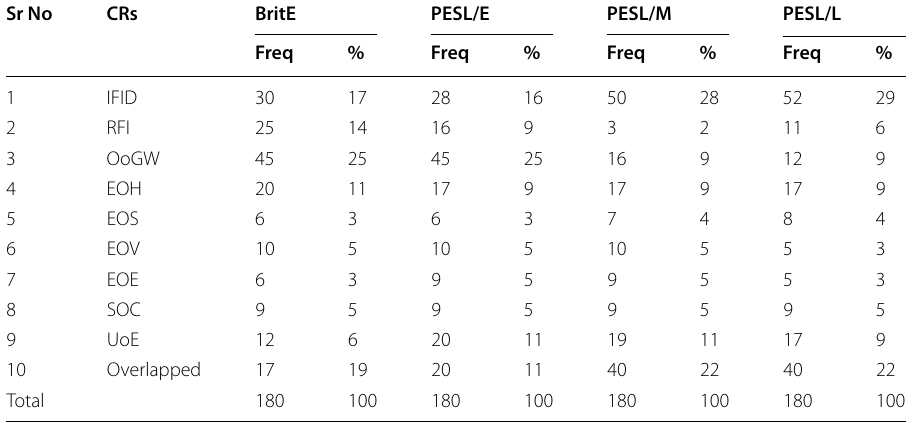
%, percentage value of the responses; RFI, Request for information; IFID, Illocutionary force indicating a device; OOGW,Offer of a good wish; EOH, Expression of happiness; EOV, Expression of validation; EOS,Expression of surprise; EOE,Expression of envy; SOC, Suggestion of